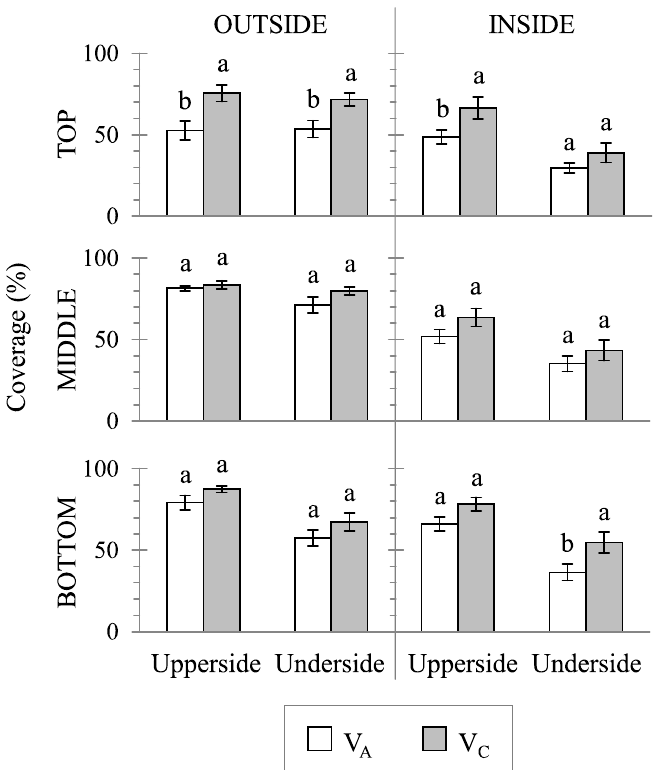
Figure 5. Mean ( ± standard error) coverage (%) per water volume (V A : adjusted, V C : conventional) at each height (top, middle, bottom) and depth (inside, outside) of the canopy, and side of the leaf (upperside, underside), of the 10 evaluations. Different letters above the bars within each height × depth × side combination indicate significant differences (LSD test, p < 0.05).